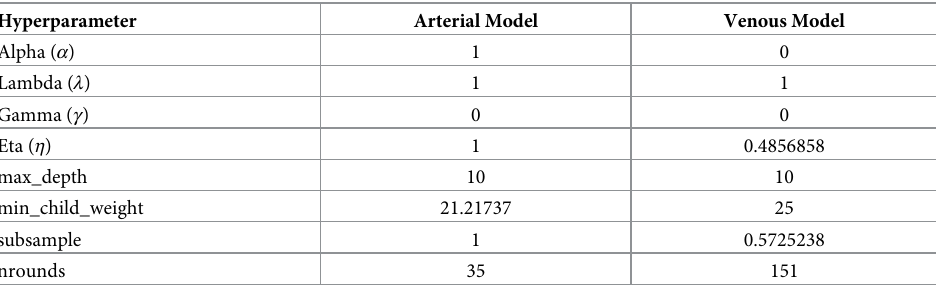
Table 1. Bayesian optimised Extreme Gradient Boost hyperparameters.